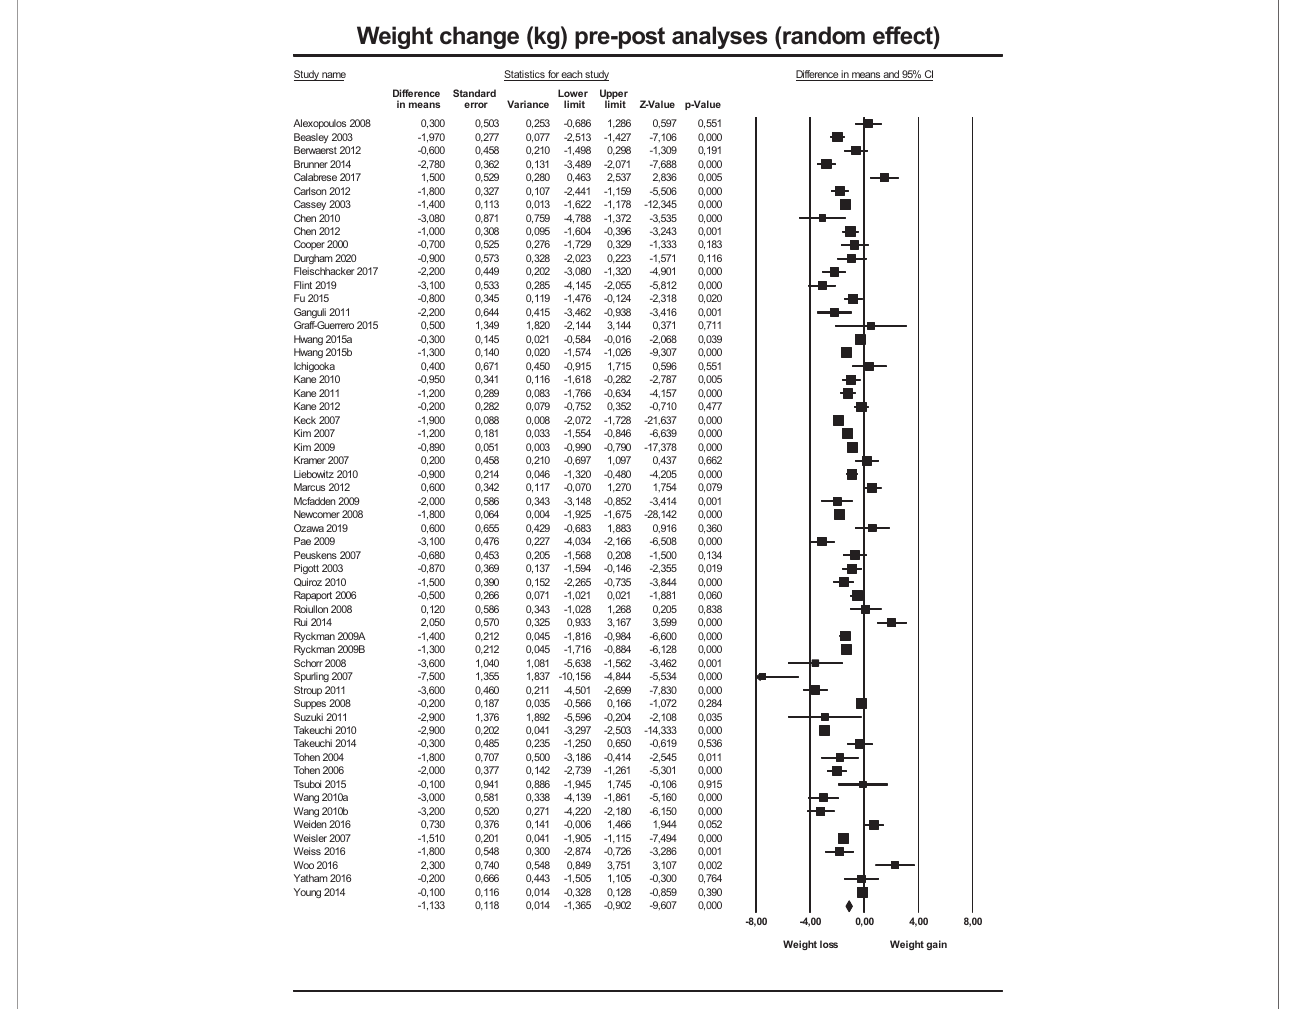
FIGURE 3 | Forest plot showing results from studies comparing pre- to post intervention change in weight.